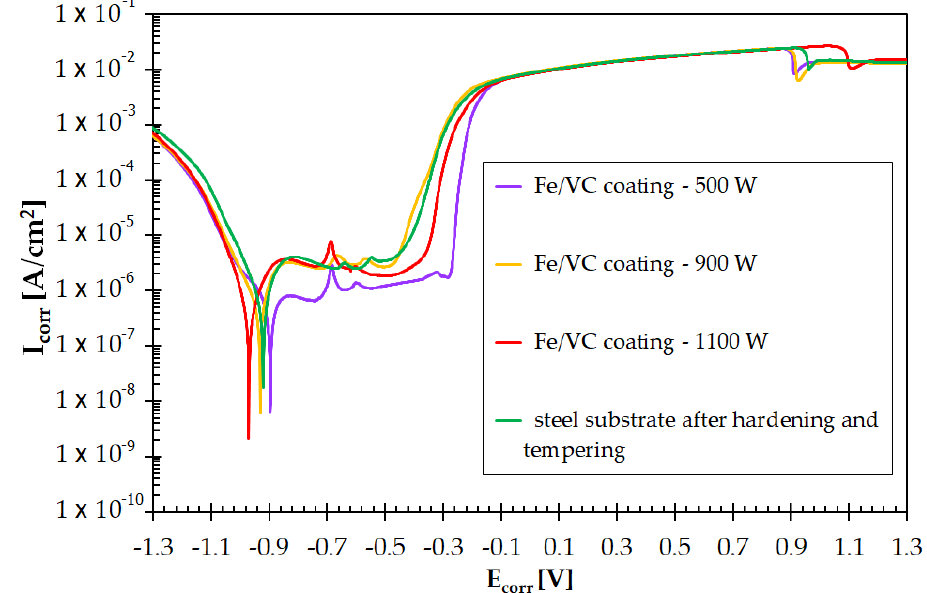
Figure 15. Corrosion resistance of the steel substrate and coatings produced using various laser beam powers: 500 W; 900 W and 1100 W.